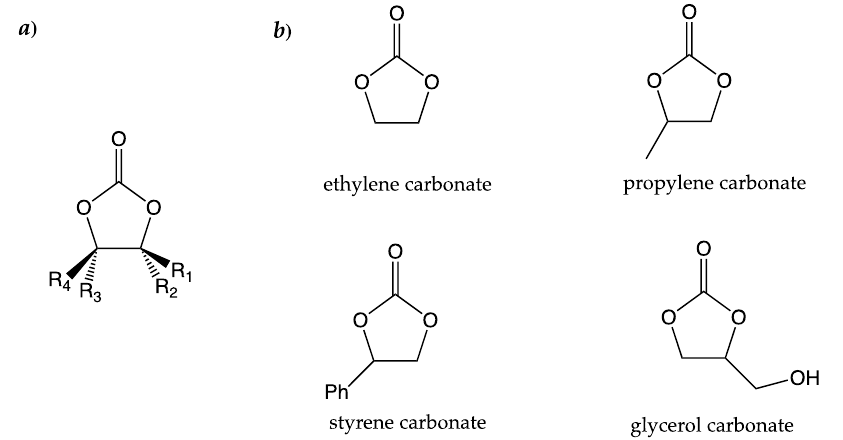
Figure 2. General structure of a cyclic carbonate ( a ) and examples of commonly produced cyclic carbonates ( b ).